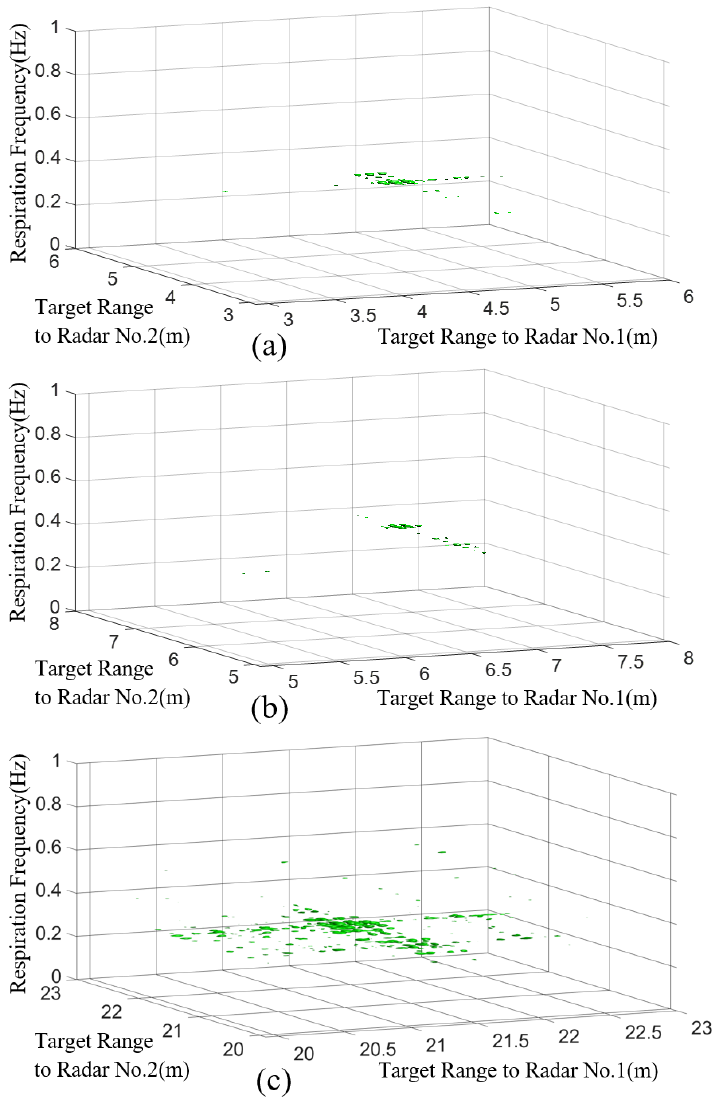
Figure 8. The output cross-correlated range-frequency 3D images. The vital sign features (VSFs) are marked in green for ( a ) the type-I, ( b ) the type-II and ( c ) the type-III experiments, respectively.